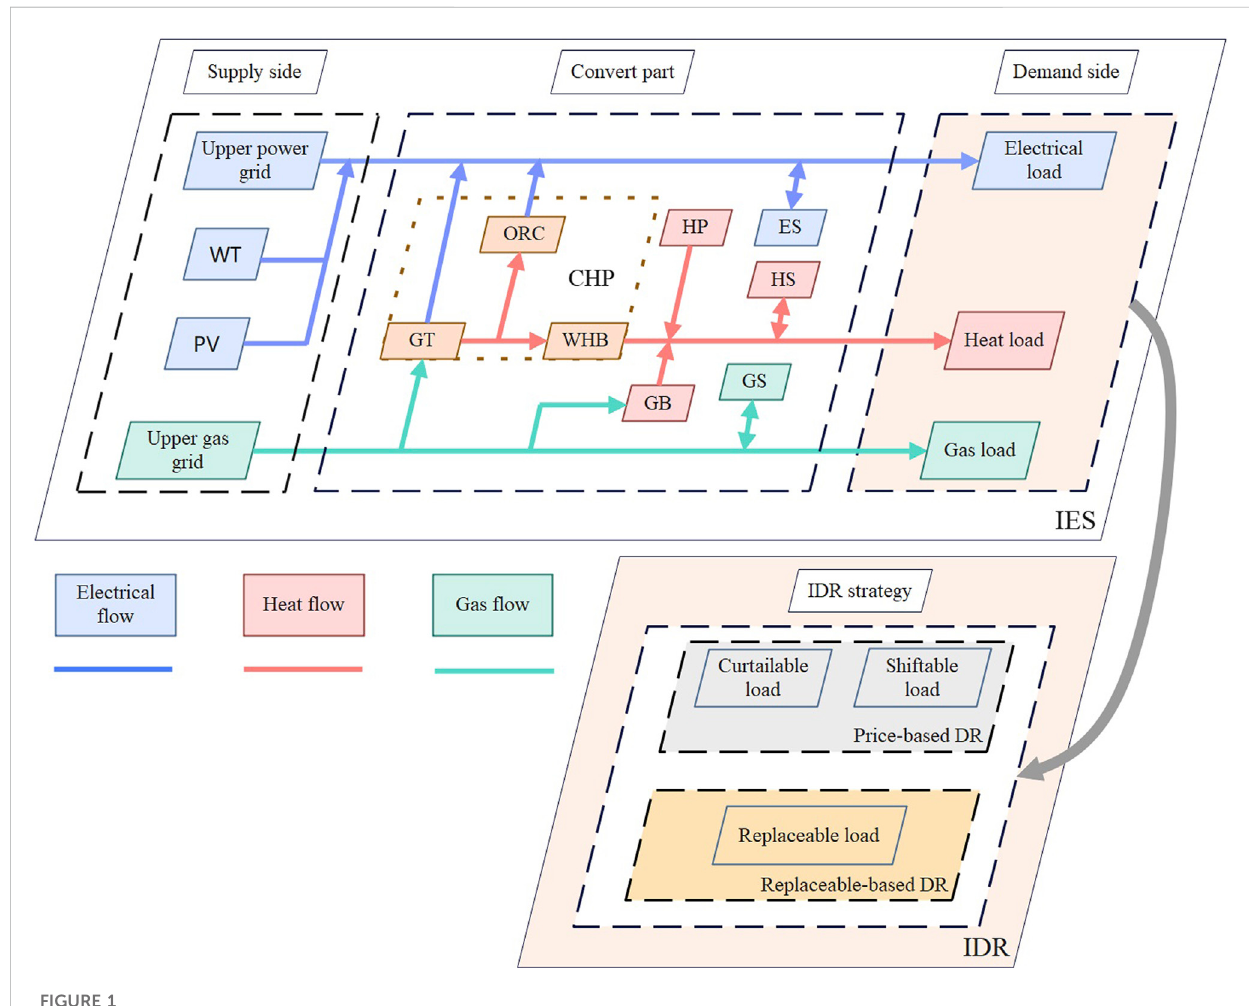
FIGURE 1 The structure of the IES and the